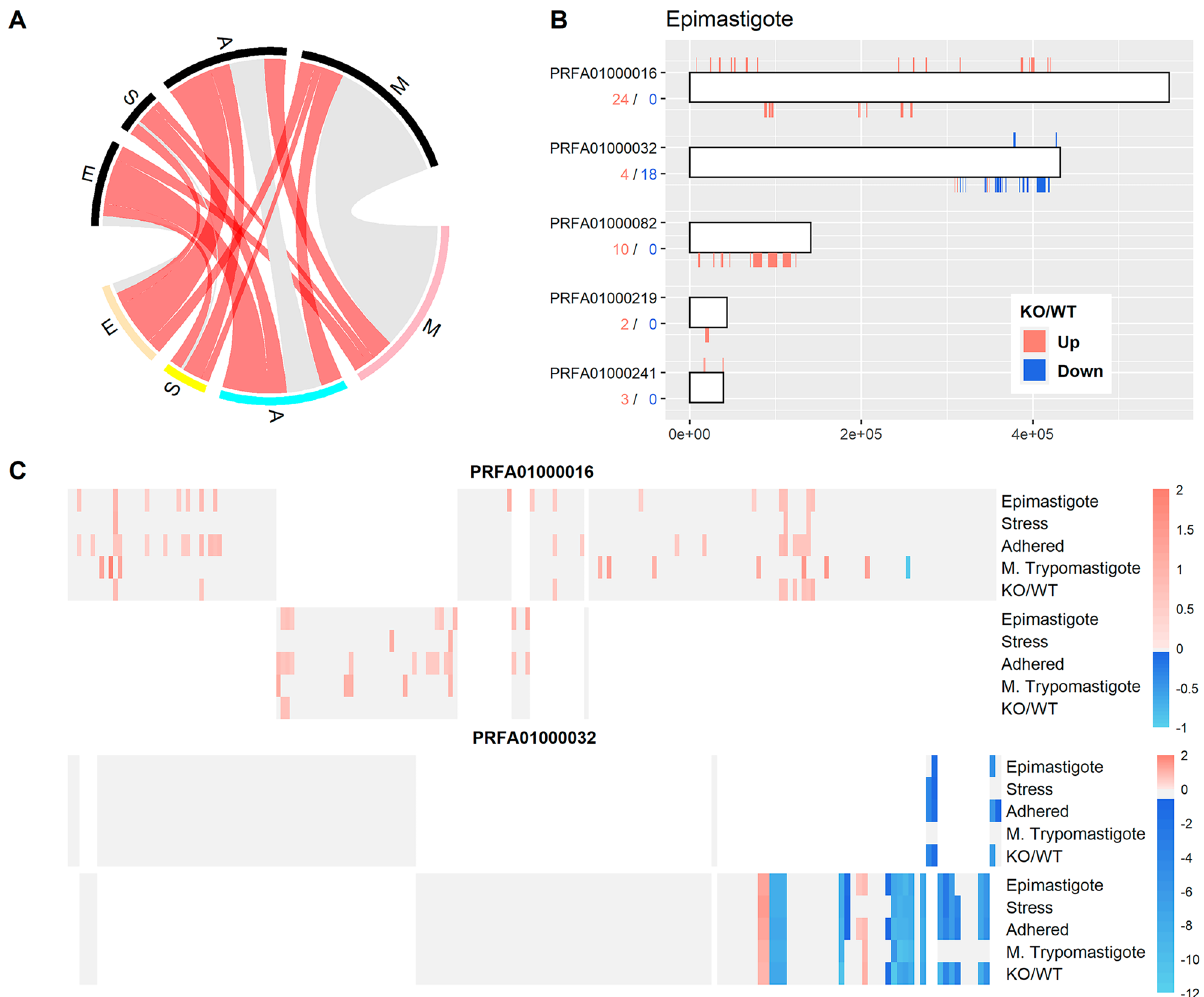
Figure 3. Differentially expressed genes in TcHDAC4 knockout mutants. ( A ) Circos plot of genes differentially expressed in the comparison KO/WT at each developmental stage indicated by the letters: E, Epimastigote (orange and black); S, Stressed epimastigotes (yellow and black); A, 24 h Adhered differentiating forms (cyan and black); M, Metacyclic Trypomastigote (pink and black). Red lines represent differentially expressed genes (KO/WT) that are shared by least two developmental stages and grey lines show genes that were identified as differentially expressed only in one developmental stage. ( B ) Clusters of genes in the top five chromosomes enriched with overrepresented regions of differentially expressed genes. Bars represent the chromosome scaled according to its size. Only genes that were identified as differentially expressed are marked as red bars or blue bars, which means up and down regulation (KO/WT), respectively; colored bars that are above the chromosome indicate the genes that are encoded in the plus strand and colored bars underneath the chromosome represent genes encoded in the minus strand. ( C ) Clusters of genes from all five comparisons along chromosomes PRFA01000016 and PRFA01000032. Each heatmap shows a chromosome and is grouped in 2 panels. The upper panel represents the genes in the plus strand and the bottom panel genes in the minus strand. Each column shows a gene, and each line shows a comparison of KO/WT at the indicated developmental stage or an overall comparison of KO/WT combining all developmental stages. Differentially expressed genes are represented by red and blue colors (z-score scale at right), which indicates up and down regulation (KO/WT), respectively. Genes that were not differentially expressed are represented in grey and absence of genes is represented in